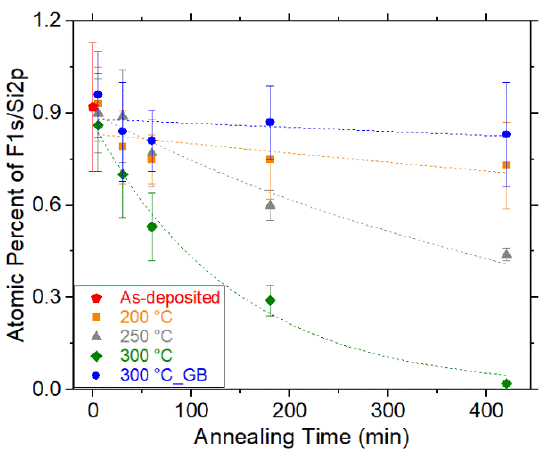
Figure 7. Thermal degradation of the FDTS monolayer displayed by the change in fluorine coverage (i.e., F 1s/Si 2p peak areas normalized by sensitivity factors) as a function of annealing time and temperature. The glove box is abbreviated as GB. Reprinted with permission from [11]. Copyright 2020 American Vacuum